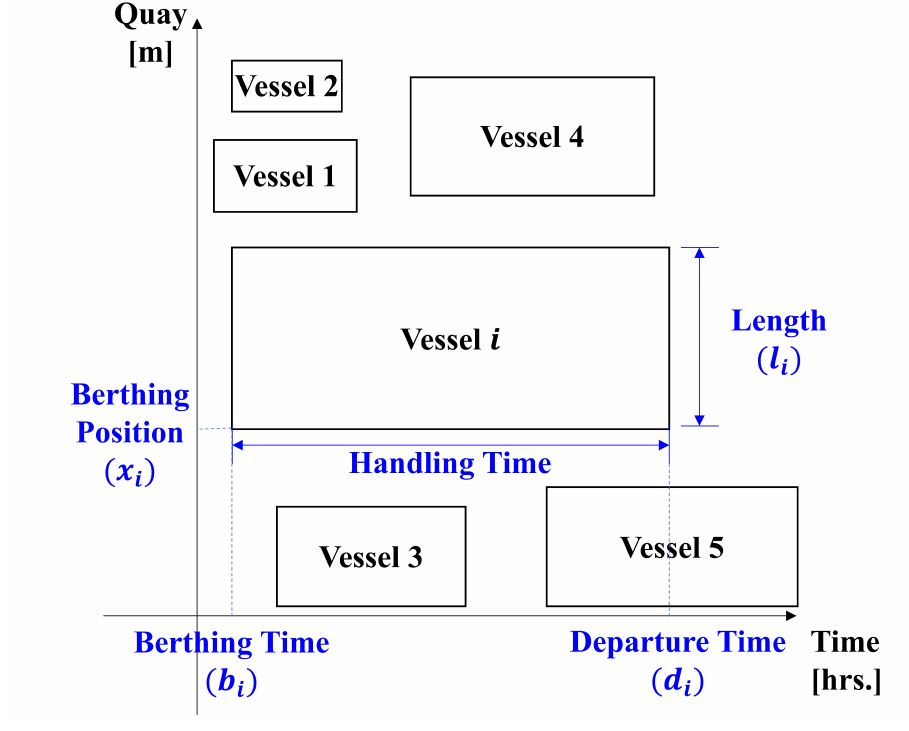
Figure 1. Time-space diagram.